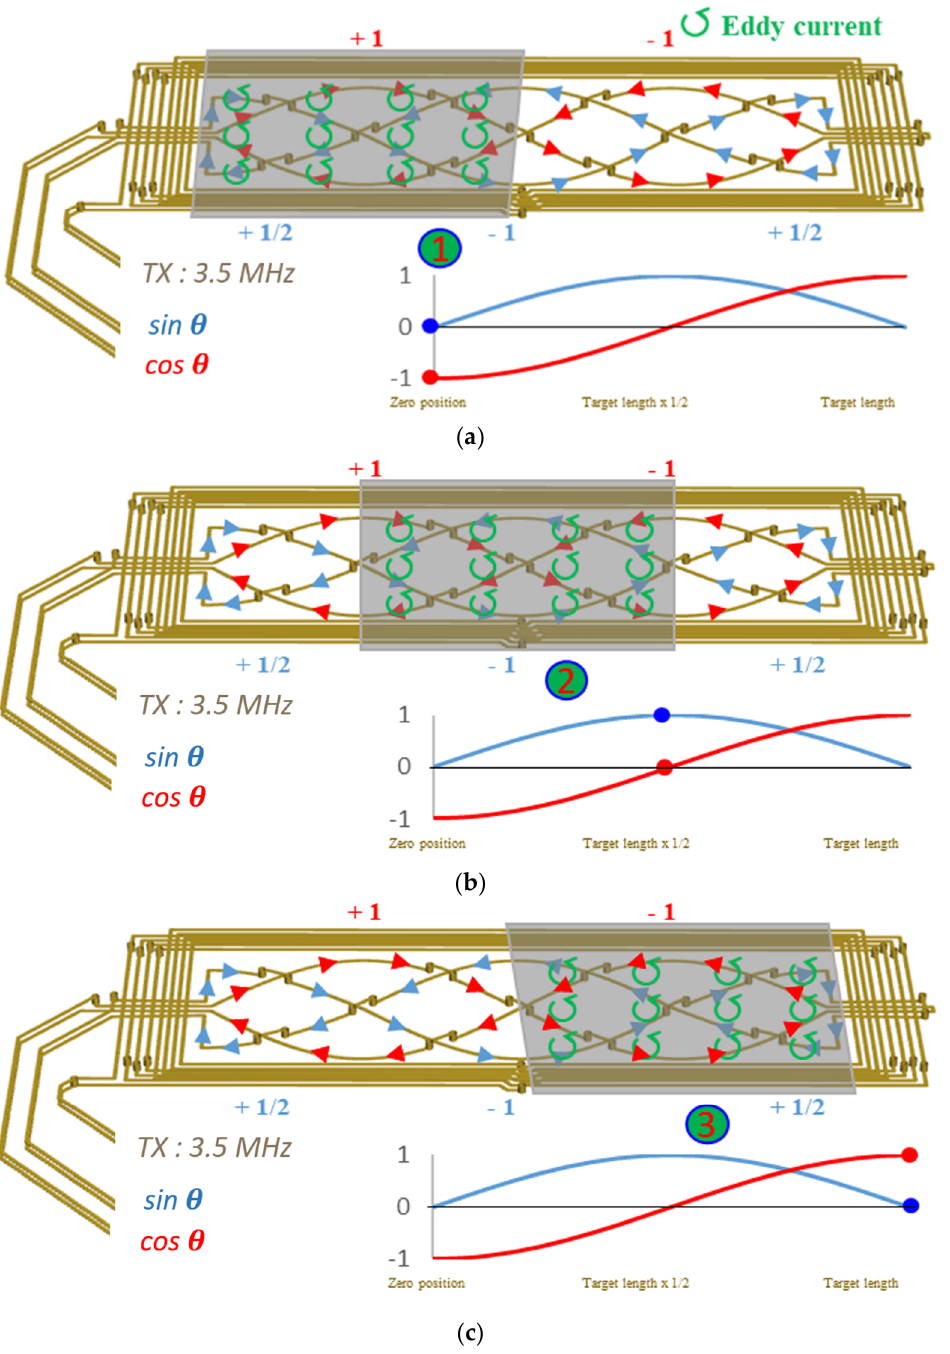
Figure 2. Inductive position sensor showing a 3.5 MHz high-frequency transmitting ( Tx ) loop and receiving ( Rx ) coils ( sin θ and cos θ ), induced current flow, and eddy currents: ( a ) zero position (0 mm) of the moveable target; ( b ) half-way position (6 mm); ( c ) final position (12 mm).